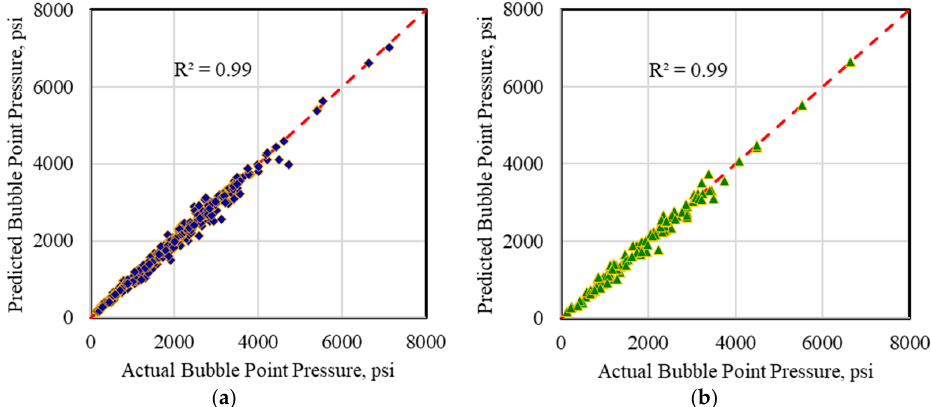
Figure 2. Cross plot between real Pb and predicted values using the self-adaptive differential evolution-artificial neural network (SaDE-ANN) model. ( a ) Training data; and ( b ) testing data.